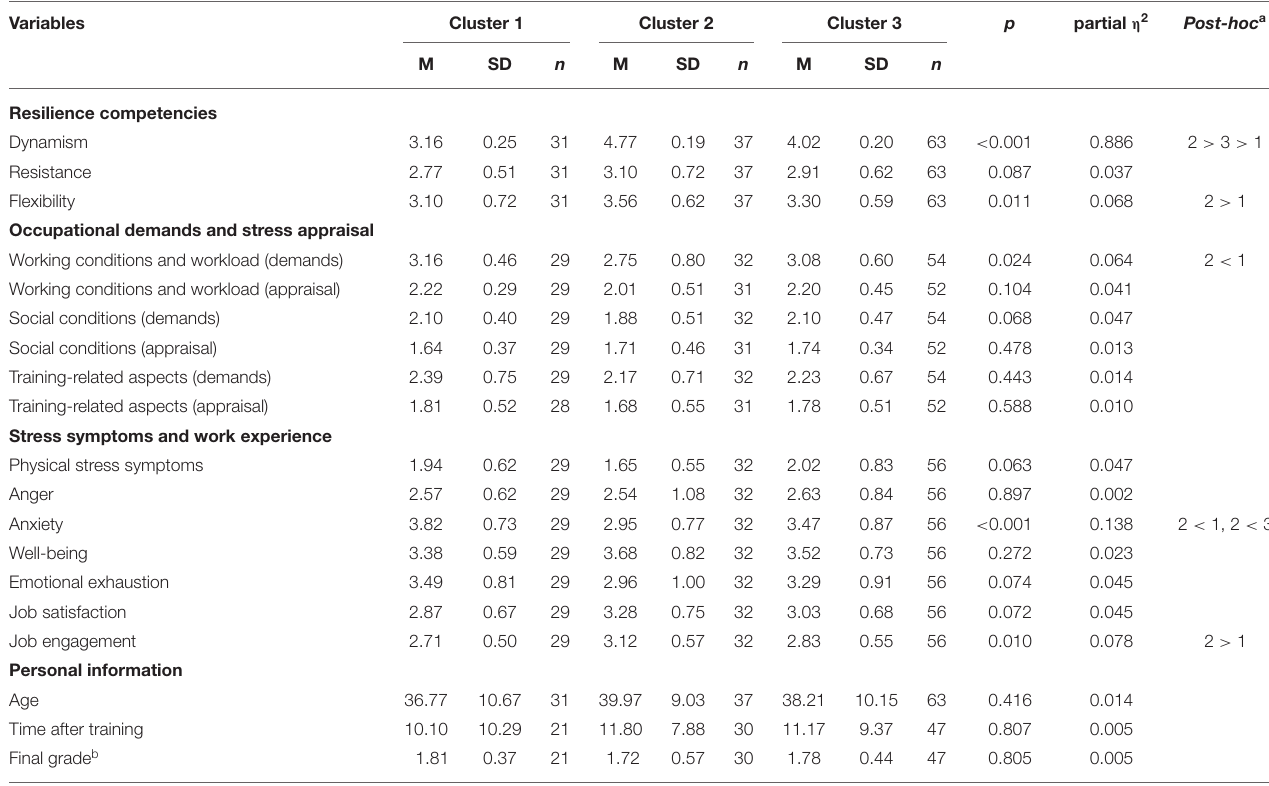
TABLE 5 | Cluster differences